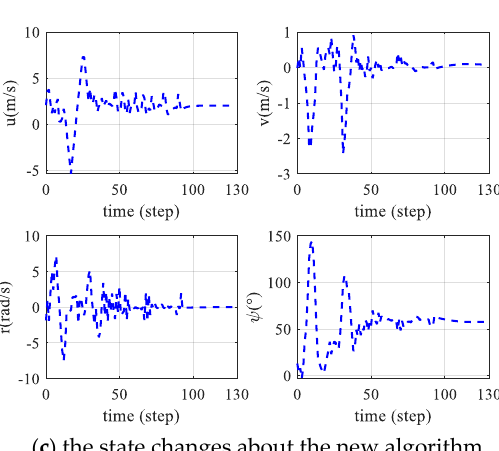
Figure 7. Comparison of algorithms under three obstacle ships.